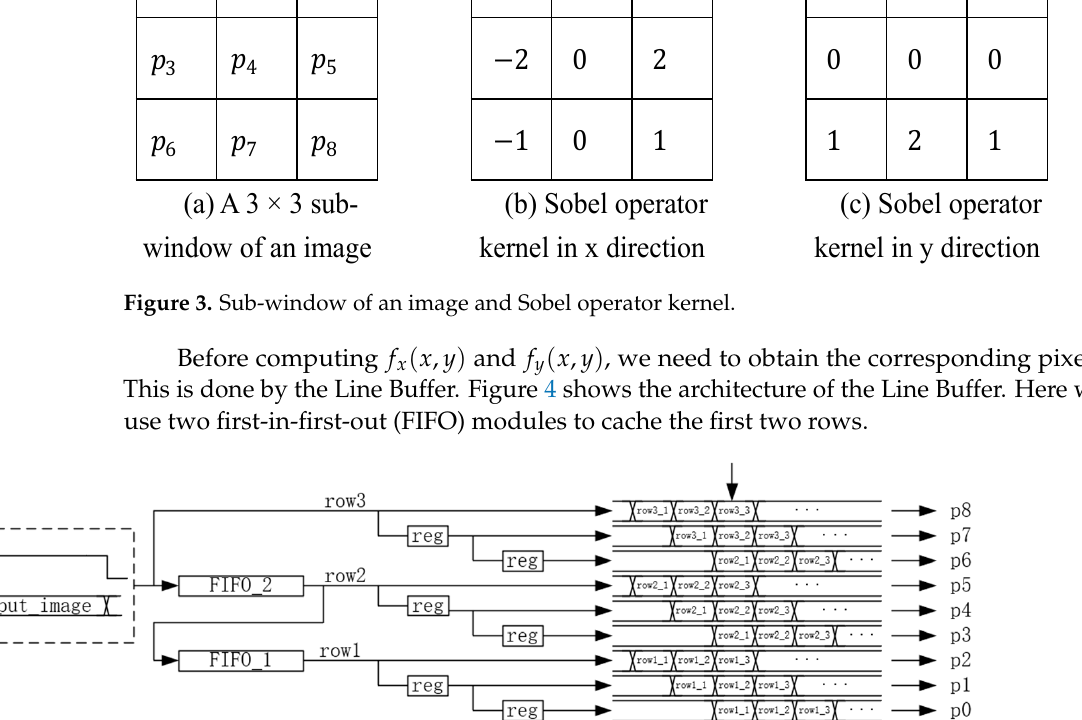
Figure 3. Sub-window of an image and Sobel operator kernel.